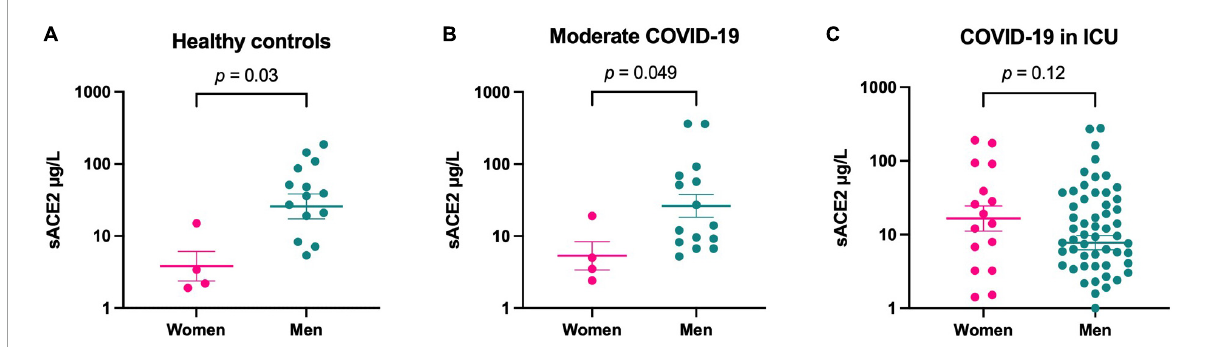
FIGURE1 Soluble form of ACE2 (sACE2) concentrations ( µ g/L) in healthy controls (A) , at hospital admission for patients with moderate COVID-19 (B) , and at hospital admission for patients with COVID-19 in the intensive care unit (ICU) (C) , divided by sex. Individual values and mean value with SEM are shown for each group. Student’s t -test was used for group comparisons.